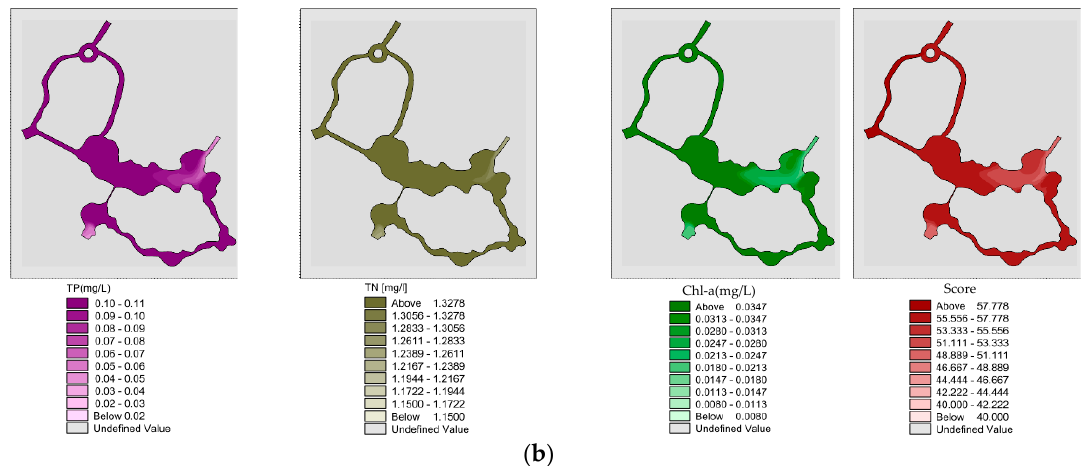
Figure 15. ( a ) Spatial distribution of “unilateral” river TP, TN, Chl-a and eutrophication comprehensive scores without water diversion in summer; ( b ) Spatial distribution of “bilateral” rivers TP, TN, Chl-a and eutrophication comprehensive scores without water diversion in summer.